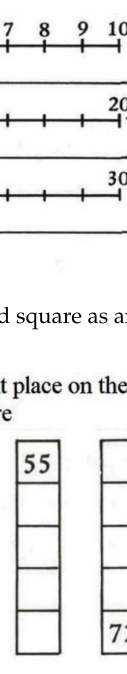
Figure 8. An exploratory activity with the one hundred square in Wiskobas [39] (p.